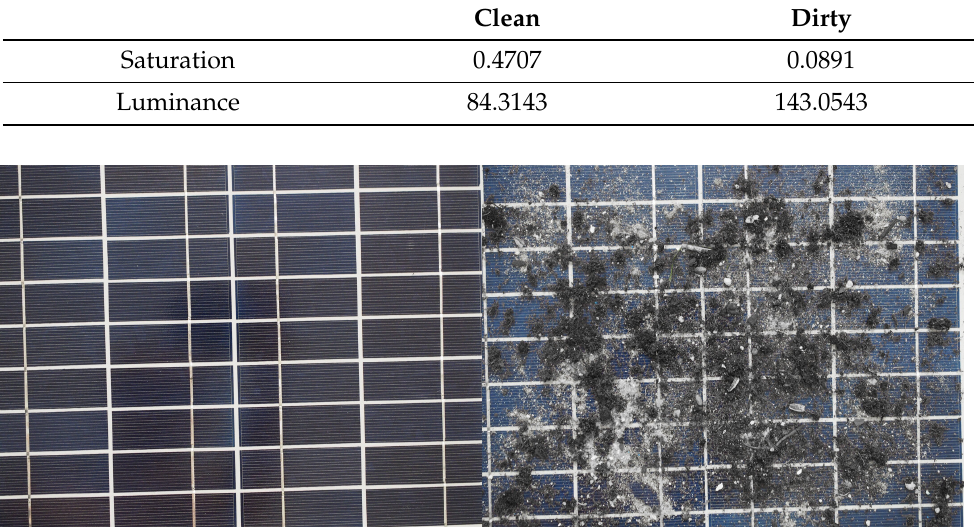
Figure 6. A clean panel ( left ) and a dirty panel ( right ) a comparison.